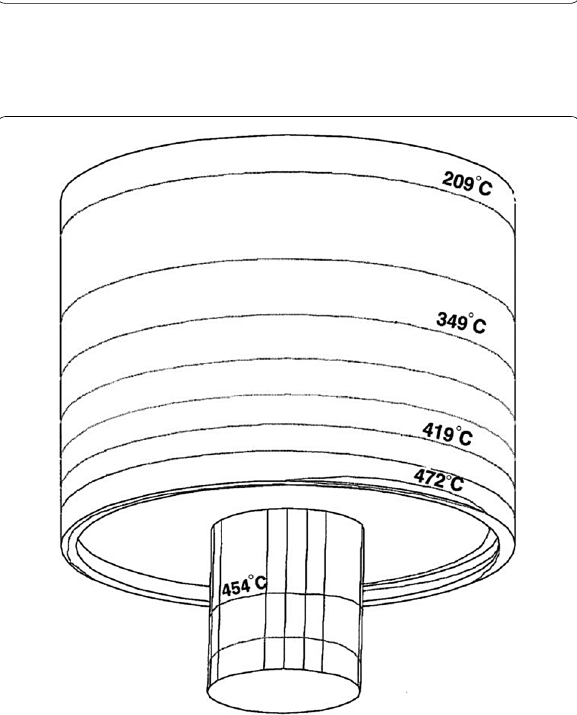
Figure 16 The predicted values of the temperature for the tool and the workpiece [73]